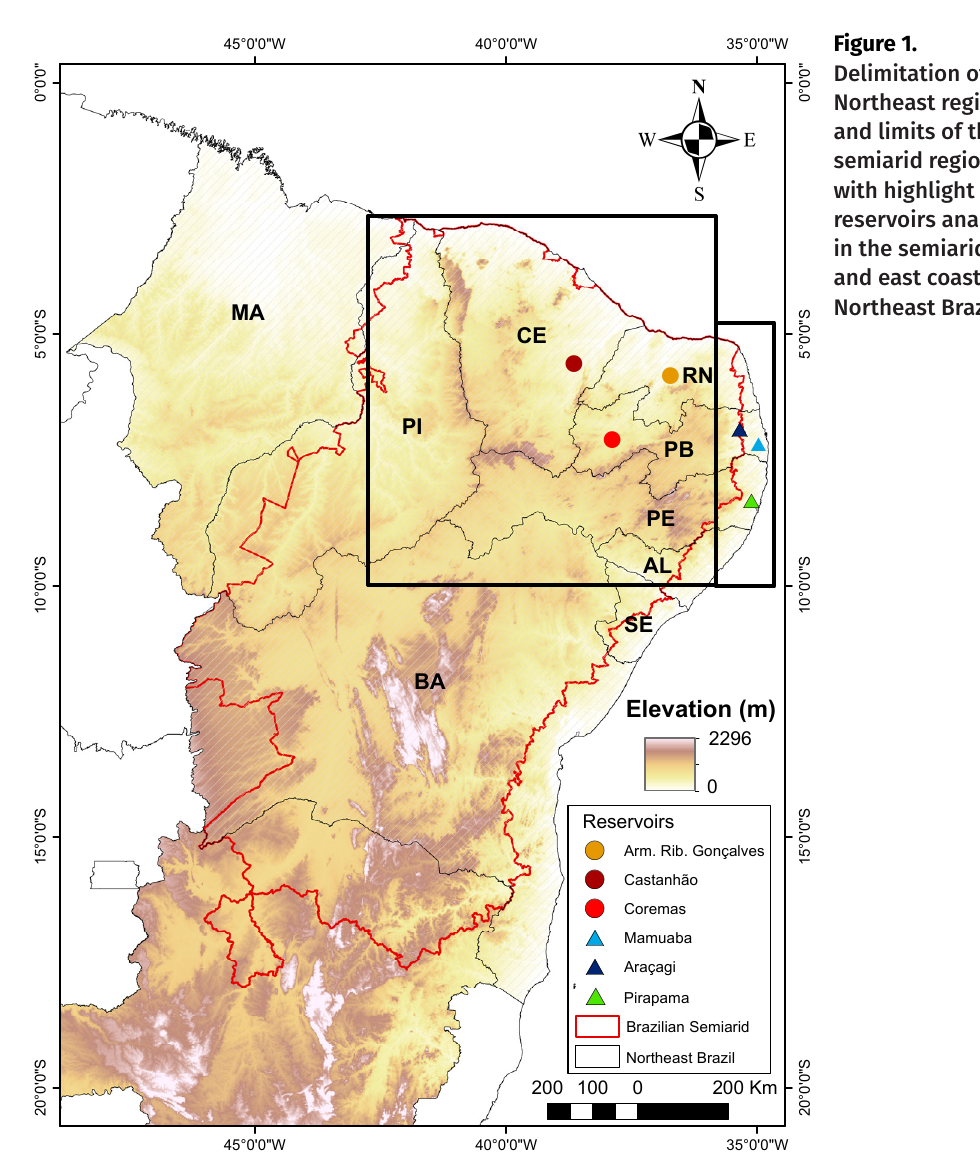
Figure 1. Delimitation of the Northeast region and limits of the semiarid region, with highlight on the reservoirs analyzed in the semiarid and east coast of Northeast